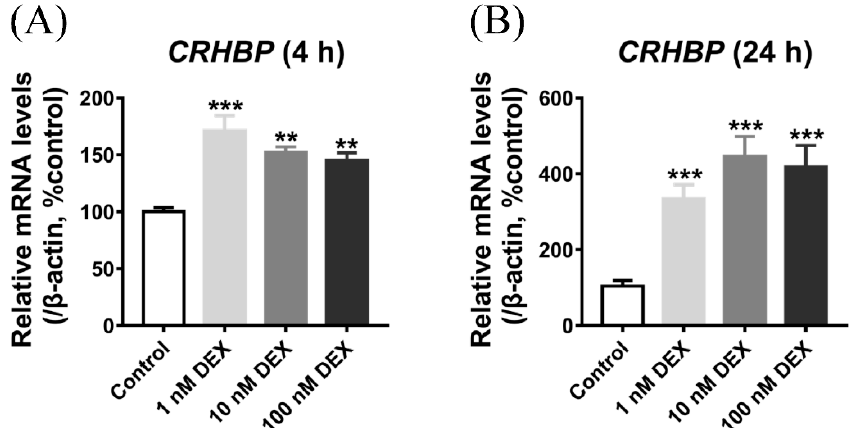
Figure 7. The effect of DEX (dexamethasone) on c CRHBP mRNA expression in cultured chick pituitary cells for 4 h treatment ( A ) and 24 h treatment ( B ). The mRNA levels were first calculated as the ration to that of β -actin and then expressed as a percentage of the control group. Each data point represents the mean ± SEM of 4 replicates ( n = 4). **, p < 0.01 vs. control; ***, p < 0.001 vs. control.